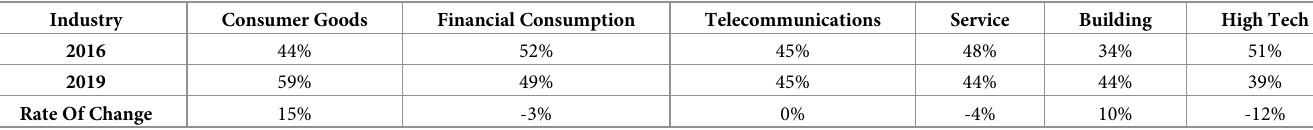
Table 7. Comparison of the number of fraud cases in various industries worldwide. Industry